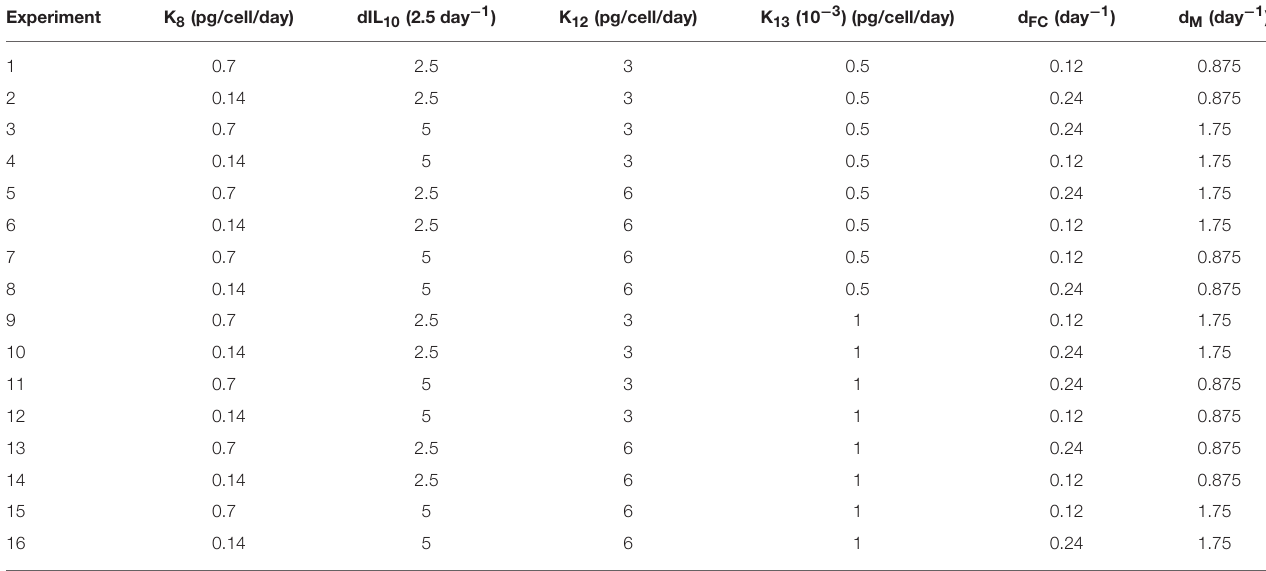
TABLE 2 | Parameters experiments.